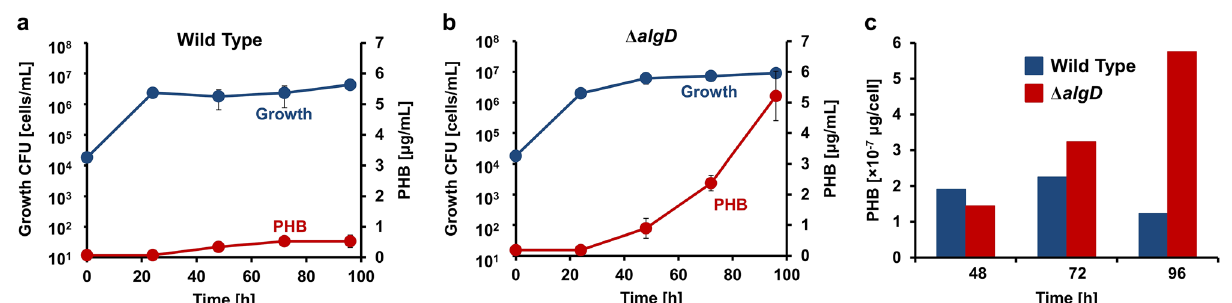
Figure 4. PHB production from crude glycerol. ( a ) Growth and PHB production (wild-type cells). Blue and red-colored circles represent growth and PHB concentration, respectively. ( b ) Growth and PHB production (mutant Δ algD cells). Blue and red-colored circles indicate growth and PHB concentration, respectively. ( c ) PHB production per cell. At each time point, blue and red-colored bars represent wild-type and mutant Δ algD cells,